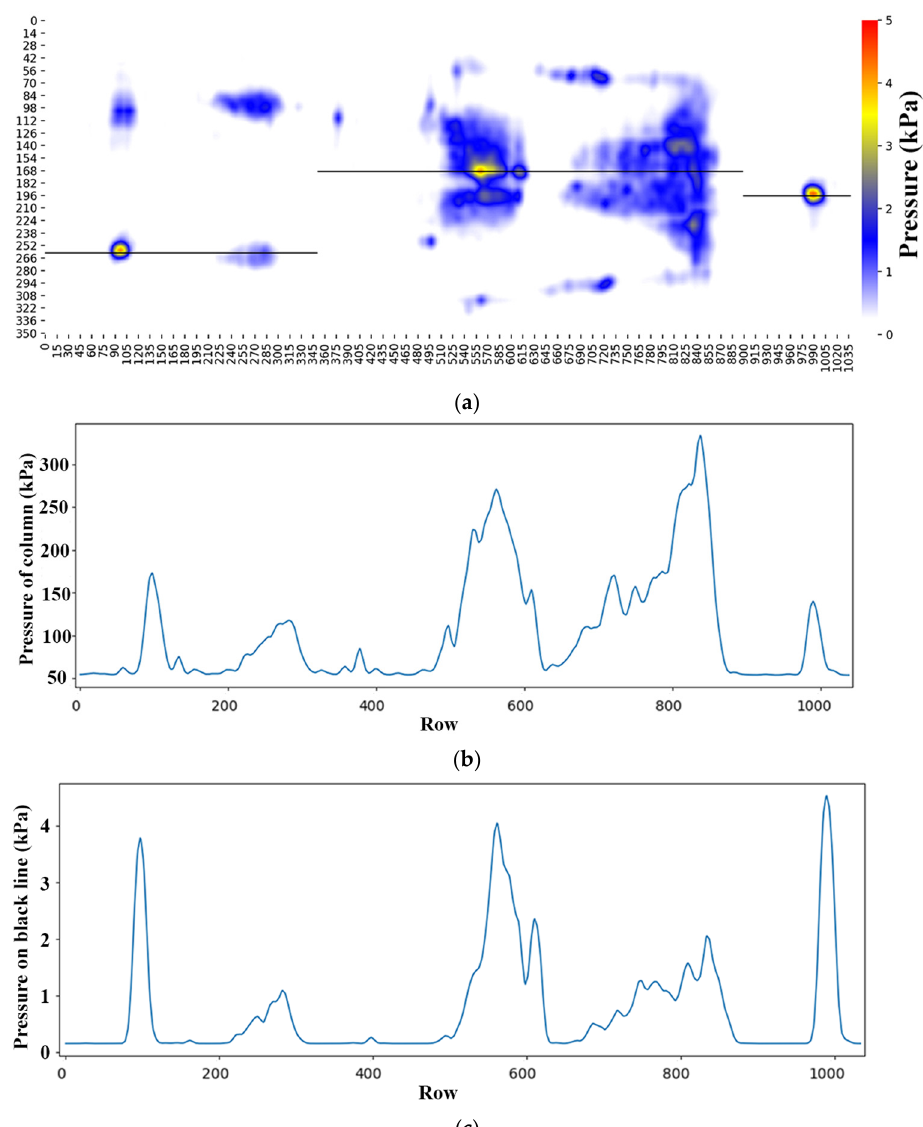
Figure https://doi.org/10. Pressure distribution comparison of a person lying down: ( a ) Pressure Figure 10. Pressure distribution comparison of a person lying down: ( a ) Pressure area; ( b ) Summation area; ( b ) Summation of column; ( c ) Pressure value in the black line. of column; ( c ) Pressure value in the black